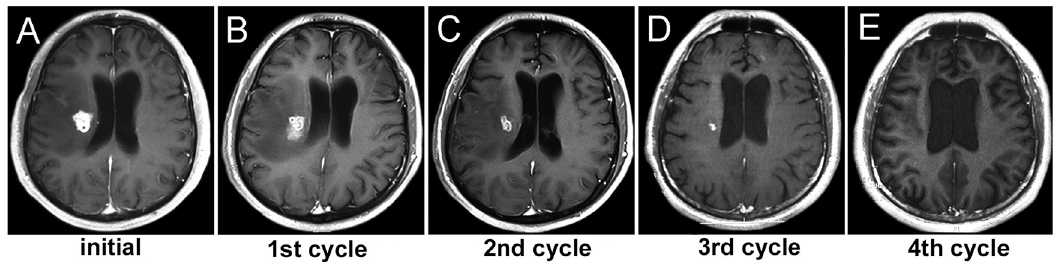
Fig 2. Dynamic cerebral MRI changes after praziquantel treatment. A 46-year-old male patient presented with left hemiplegia for three weeks and was diagnosed as cerebral sparganosis. He was treated with praziquantel (50mg/kg/day) in three divided doses for 10 days, and then the treatment cycle was repeated with monthly intervals until the active lesion completely disappeared on enhanced MRI. The initial enhanced MRI showed the aggregated ring-like lesions combined with severe edema at the right of periventricular (A). After the first treatment cycle, the lesion reduced a little in size (B). After the second treatment cycle, the lesion was obviously smaller (C). After the third treatment cycle, the lesion showed a resolution of swelling (D). After the fourth treatment cycle, the lesion had completely disappeared (E).